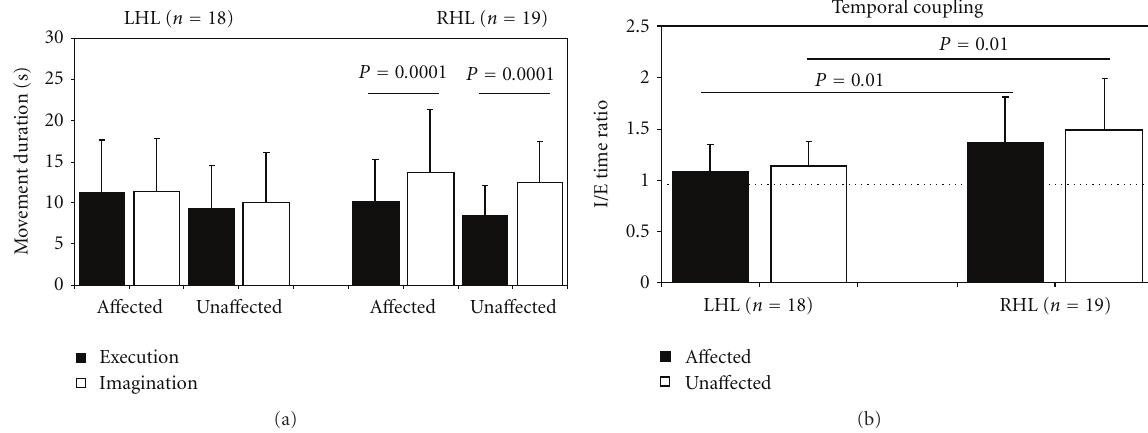
Figure 2: (a) Mean duration (1SD) of stepping movements during physical execution and mental simulation conditions on a ff ected and una ff ected sides in the subgroups of patients with a left hemispheric (LHL) and a right hemispheric (RHL) lesion. Note that the RHL subgroup, in contrast to the LHL subgroup, had longer movement times during the imagination condition. (b) Corresponding imagination/execution time ratios for dominant and nondominant sides in each subgroup of patients with an LHL or an RHL. Dotted line indicates temporal congruence of 1 to 1.